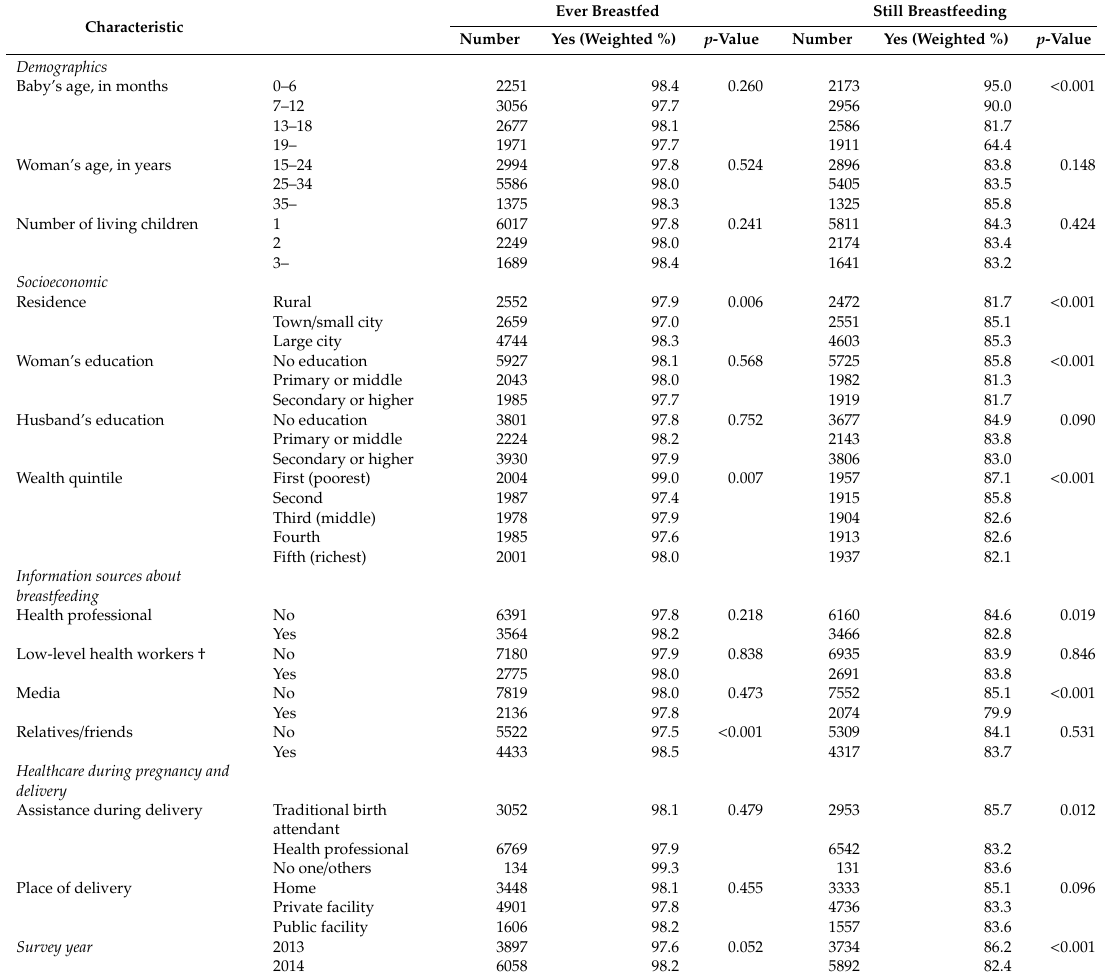
Table 1. Characteristics of survey respondents by breastfeeding status (n =